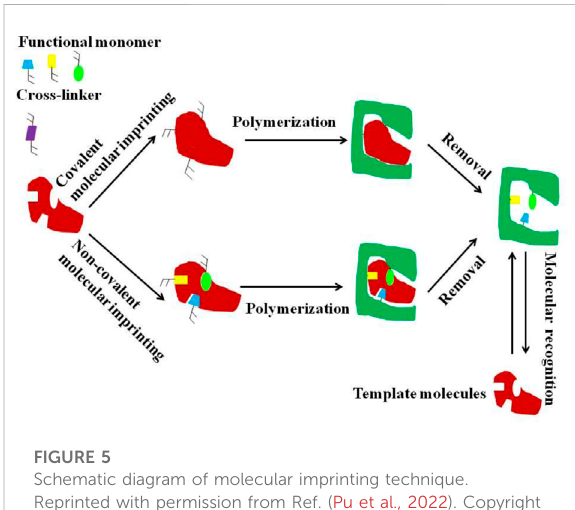
FIGURE 5 Schematic diagram of molecular imprinting